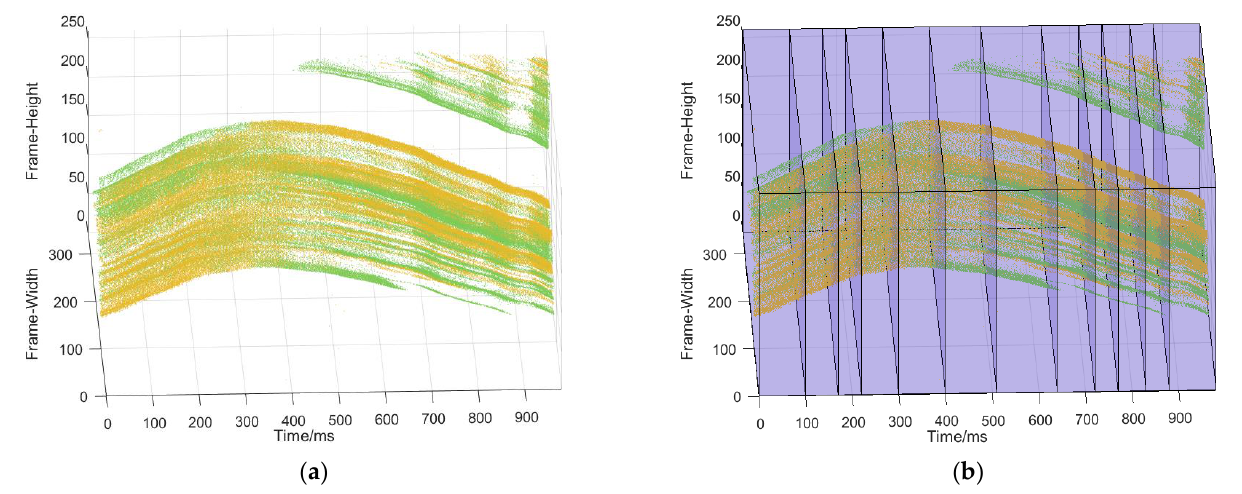
Figure 3. ( a ) spatiotemporal data stream of the event camera; ( b ) spiking input event representation obtained by [7].